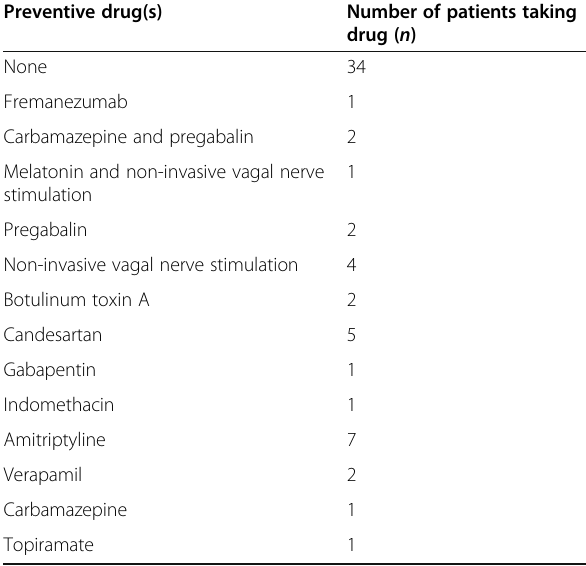
Table 1 Summary of preventive drugs taken by patients in cohort